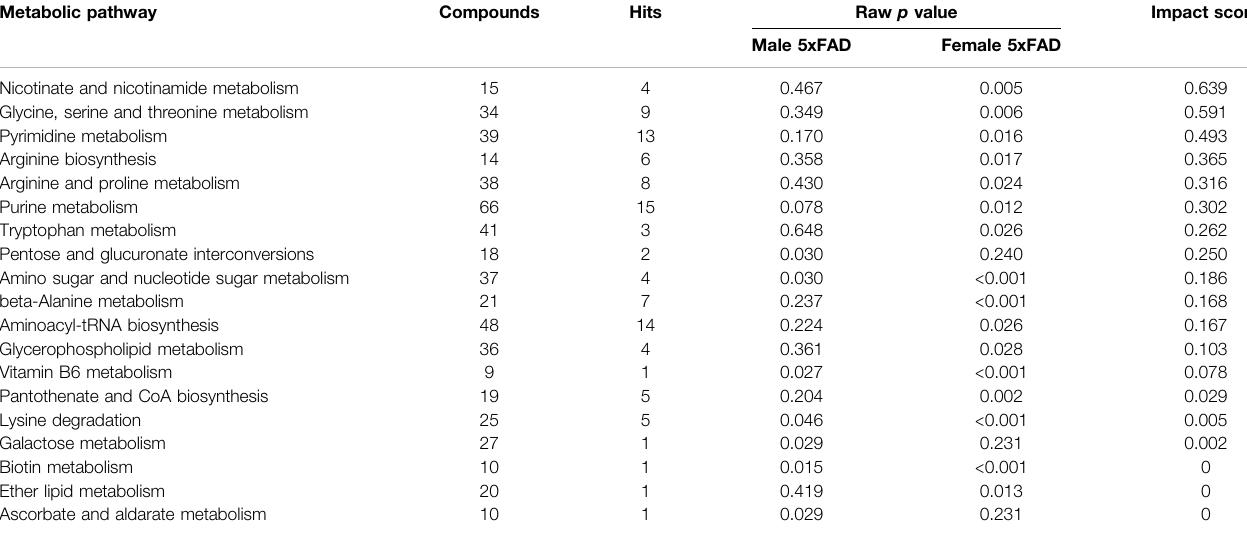
TABLE 2 | Pathway analysis comparing male and female 5xFAD mice to male and female wild-type (WT) mice, respectively. Metabolic pathway Compounds Hits Raw p value